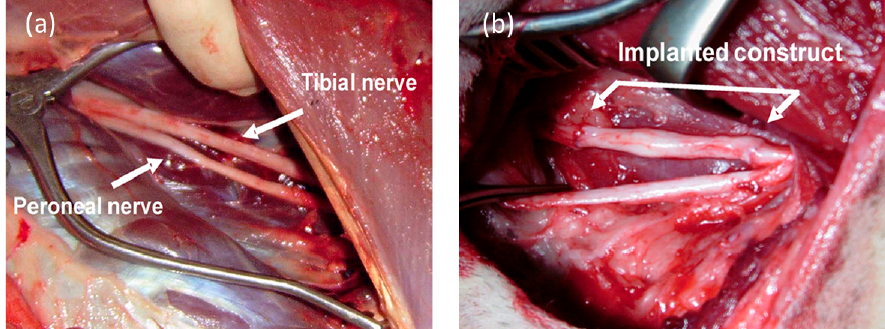
Figure 1. Nerve defect induction in sheep peripheral nerve and spider silk–based construct implantation. ( a ) Tibial and peroneal nerves (arrow head) in the sheep; ( b ) Six cm nerve defect and bridging of nerve defect with vein/spider silk construct sutured between proximal and distal nerve stumps of the nerve defect in an adult sheep. From Radtke et al., 2011 [48].